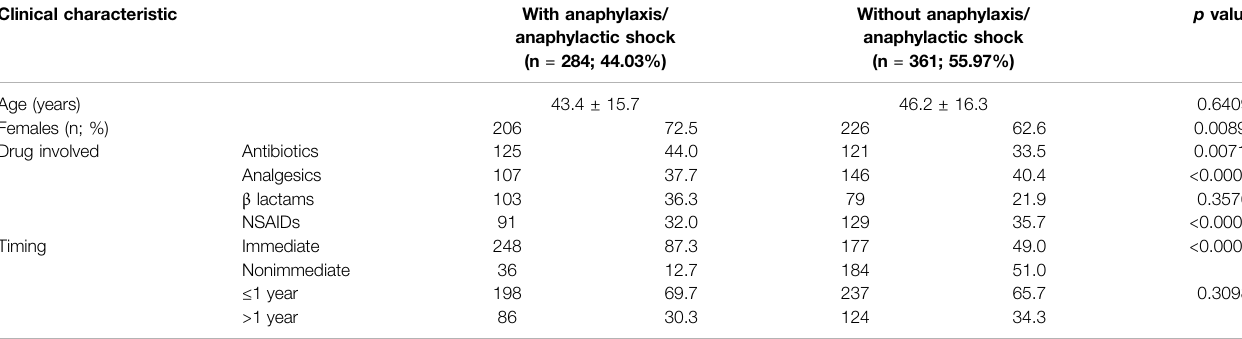
TABLE 6 | Clinical characteristics of patients with con fi rmed drug allergy in regard to anaphylaxis. Clinical characteristic